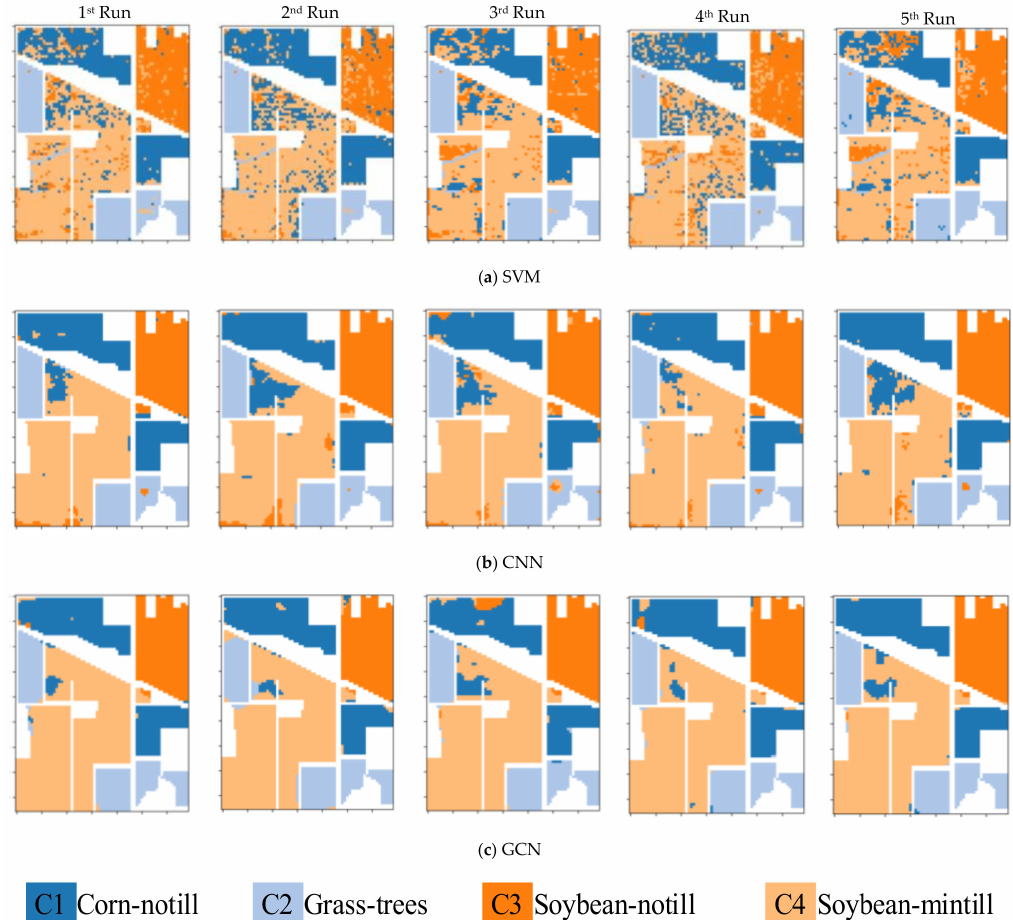
Figure 6. The classification maps of the presented GCN and its competitors, i.e., SVM and CNN, in five times random run for the IA dataset. The 1st, 2nd, and 3rd rows correspond to the ( a ) SVM, ( b ) CNN, and ( c ) GCN algorithms, respectively. Meanwhile, the 1st, 2nd, 3rd, 4th, and 5th columns correspond to different random runs,